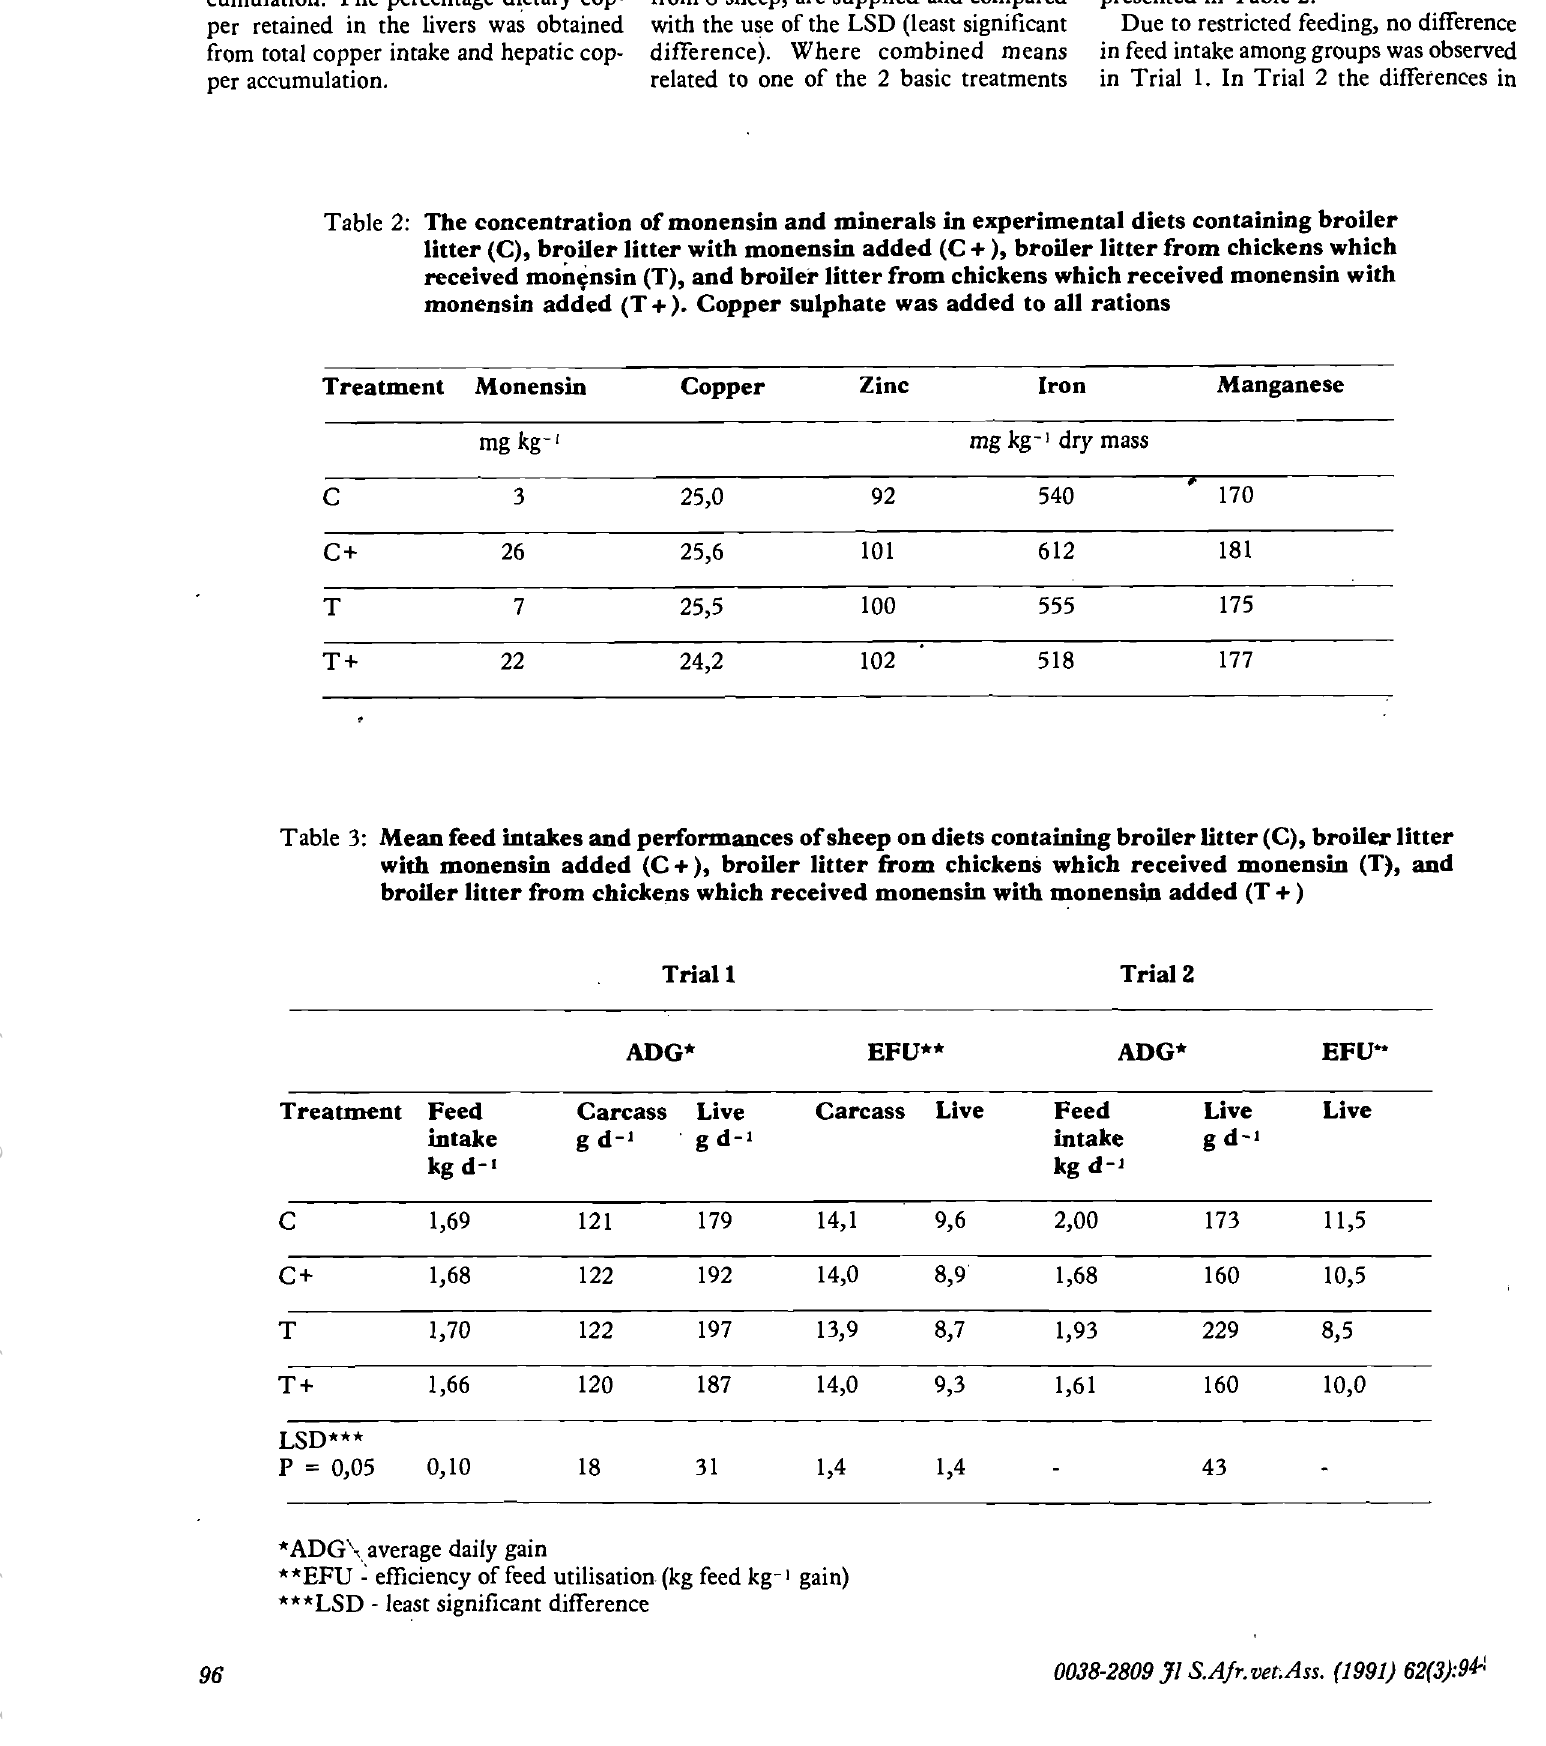
Table 2: The concentration of monensin and minerals in experimental diets containing broiler litter (C), broiler litter with monensin added (C + ), broiler litter from chickens which received mon~nsin (T), and broiler litter from chickens which received monensin with